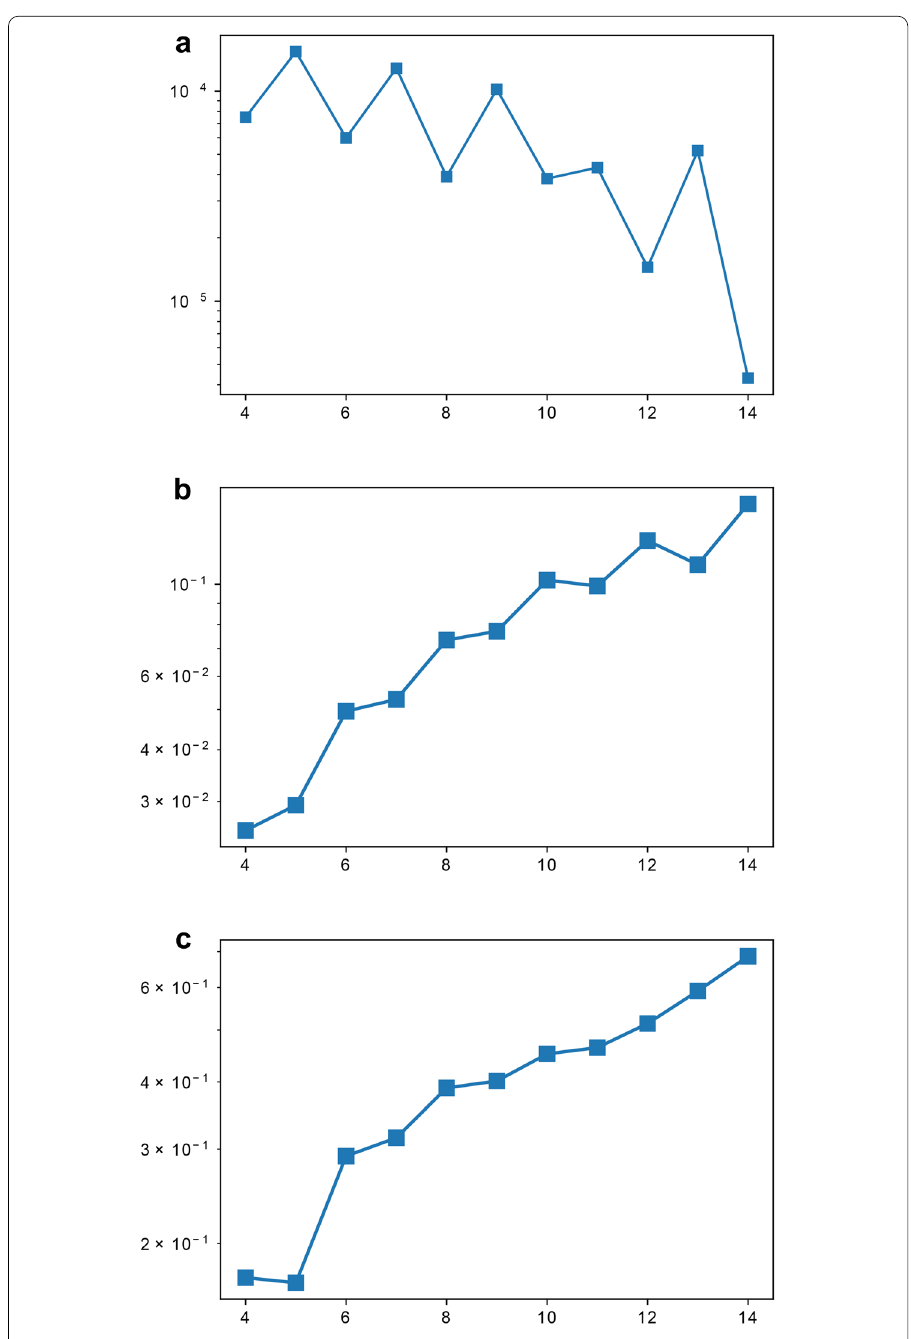
Fig. 18 Evolution of the error ( a ), the time step ( b ) and the computation time ( c ) with the order N of truncature of the time series in BPL